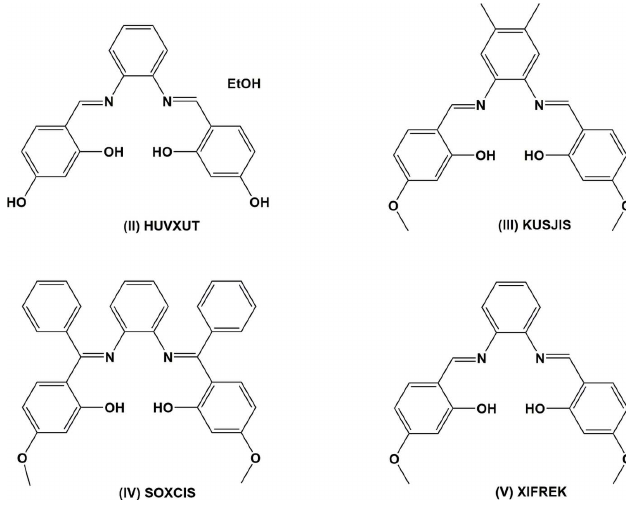
Figure 5 Similar compounds to that of the title compound, (I), in the CSD; see Section 4, Database survey .